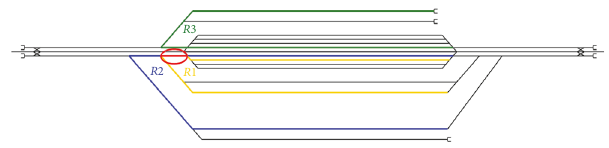
Figure 5: Diagram of train route